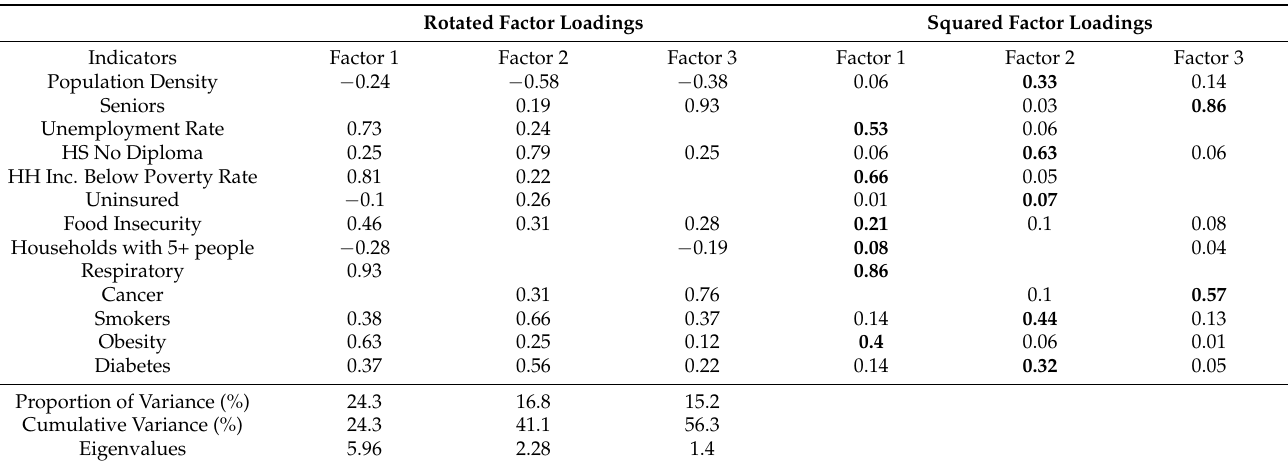
Table 4. Overall, most of the indicators with the highest weights were loaded into Factor 1. Table 3. Factor loadings for the exposure